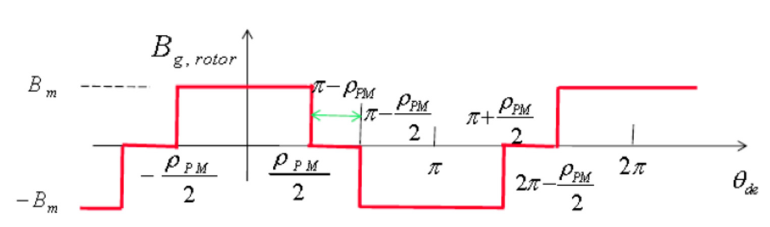
Figure 8. Simplified IPMBLDC motor air-gap magnetic